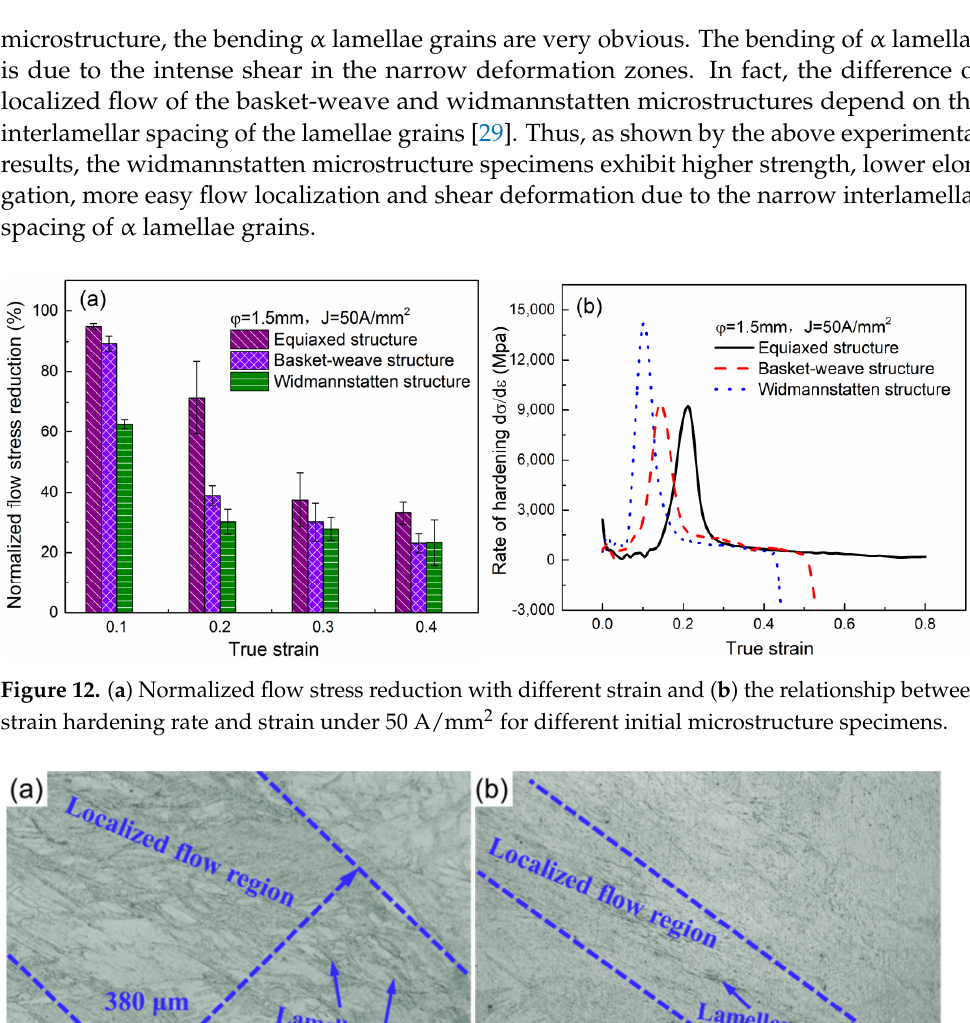
Figure 13. The microstructure of cross section of the compressed specimens for ( a ) basket-weave microstructure and ( b ) widmannstatten microstructure under 50 A/mm 2 .